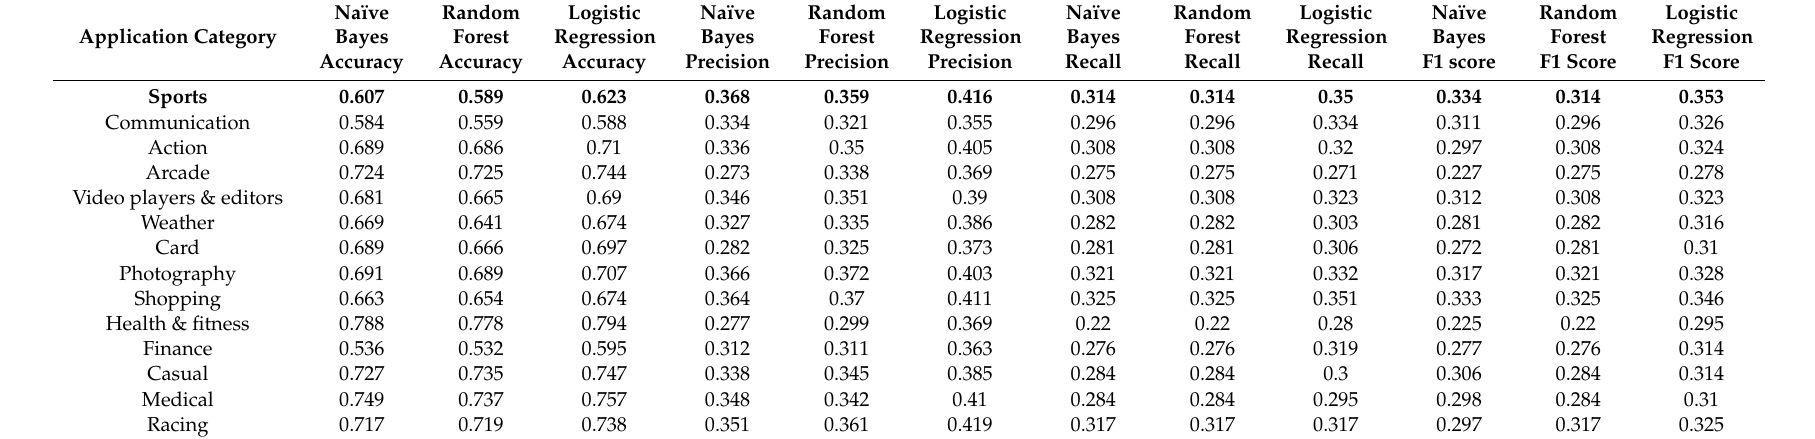
Table 4. Di ff erent machine-learning algorithm comparison on TF based without preprocessing of the dataset.